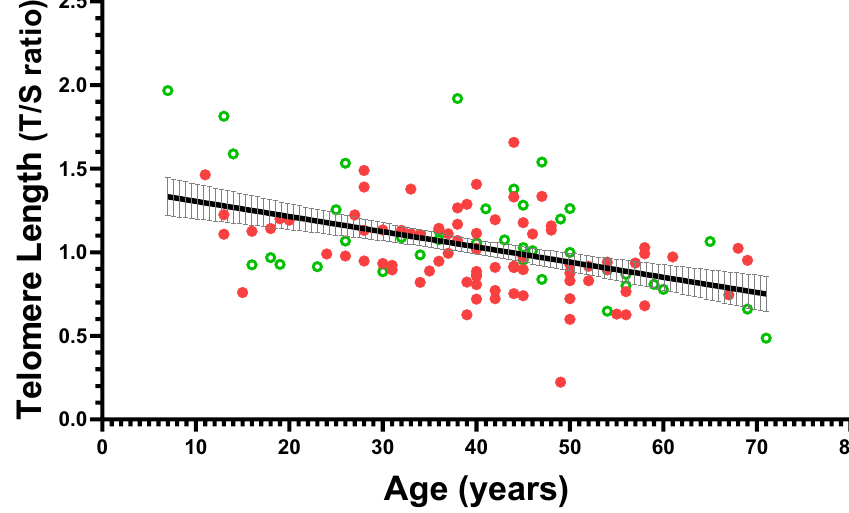
Figure 2. Relation between leukocyte TL and age among 122 participants with pulmonary tuberculosis, of whom 81 were miners (full symbols) and 41 were non-miners (open symbols). The crude Pearson’s regression line is shown (with 95% confidence interval) and has a slope of − 0.009 (95% CI − 0.012 to − 0.006); R 2 = 0.21. Leukocyte TL is expressed in relative units as the ratio of telomere copy number to single-copy gene number (T/S) relative to the average T/S ratio of the entire sample set (n = 122).